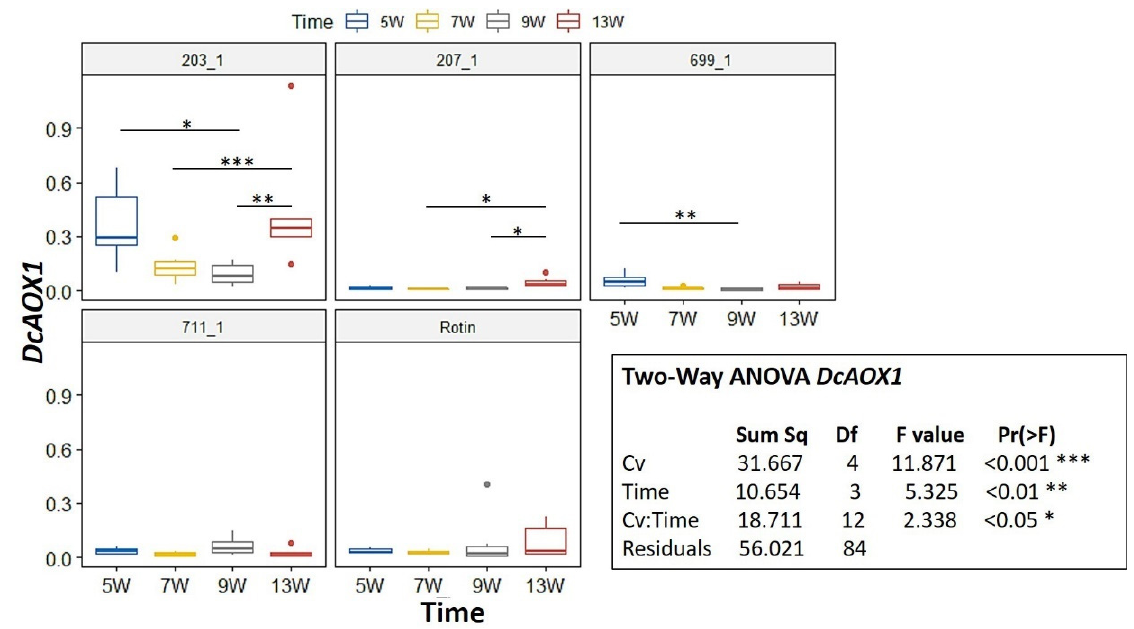
Figure 3. Expression box-plot and two-way ANOVA analysis for DcAOX1 during carrot root secondary growth in the cultivars (Cv) 203-1, 207-1, 699-1, 711-1 and ‘Rotin’. Transcript levels were determined by RT-qPCR. For each time point, four to six biological replicates were considered per cultivar. Significant differences in gene expression between time points are indicated by * ( p < 0.05), ** ( p < 0.01) or *** ( p < 0.001). Boxplots show the distributions (median, spread and outliers) of the gene expression values.